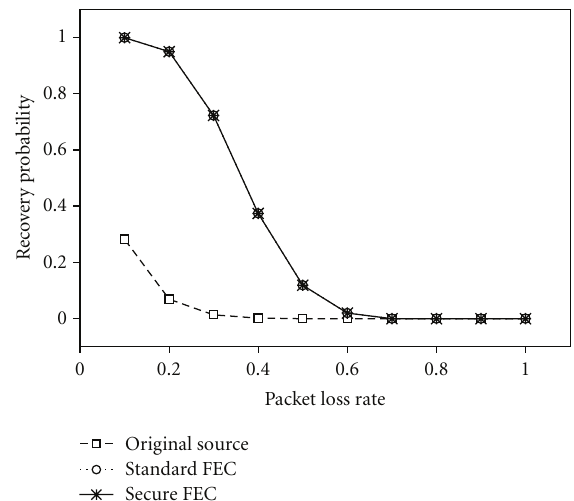
Figure 5: Observation on parameter changes with varied target recovery probabilities. The values of k 1 and P B are 12 and 0.3,